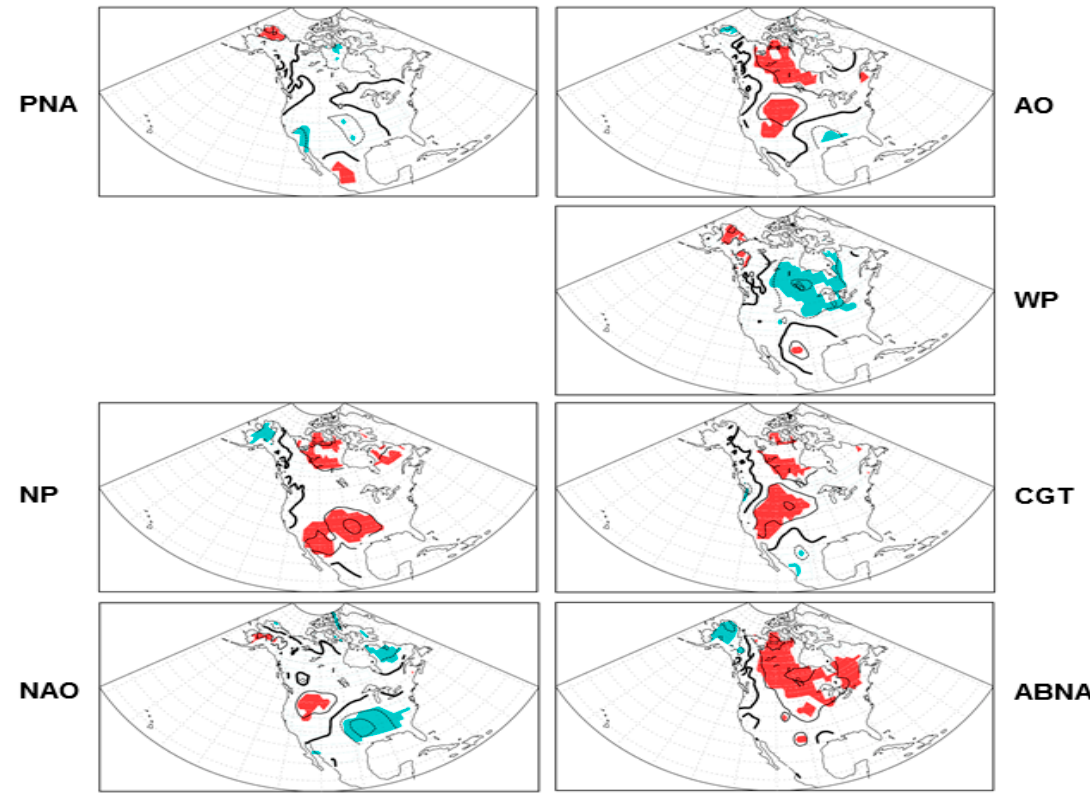
Figure 7. As in Figure 3, but for the JJA mean T 2m anomalies.